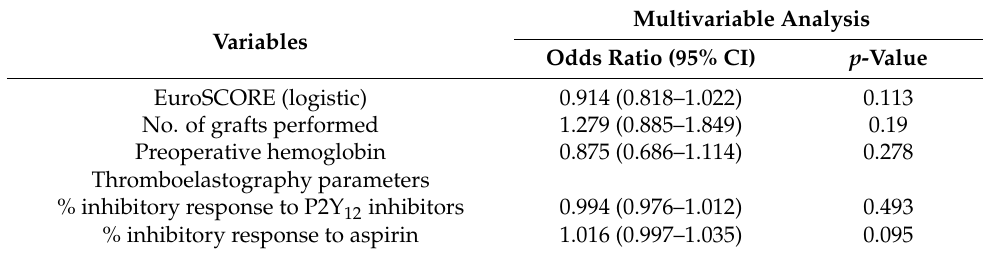
Table 4. Predictive power of chosen